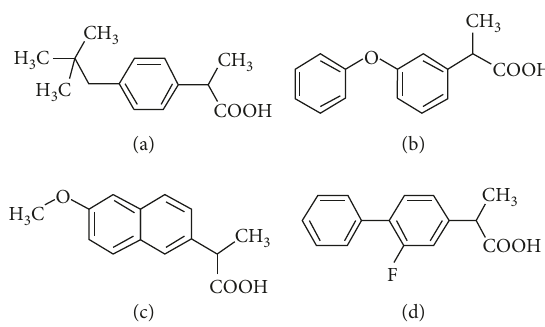
Figure 1: The molecular structures of the analyzed compounds.